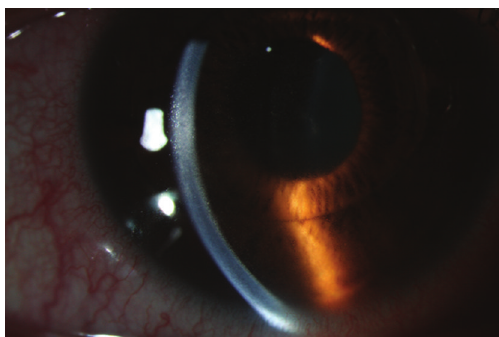
Figure 1: Toxic anterior segment syndrome (TASS) in the right eye, one day after implantation of a foldable Artiflex